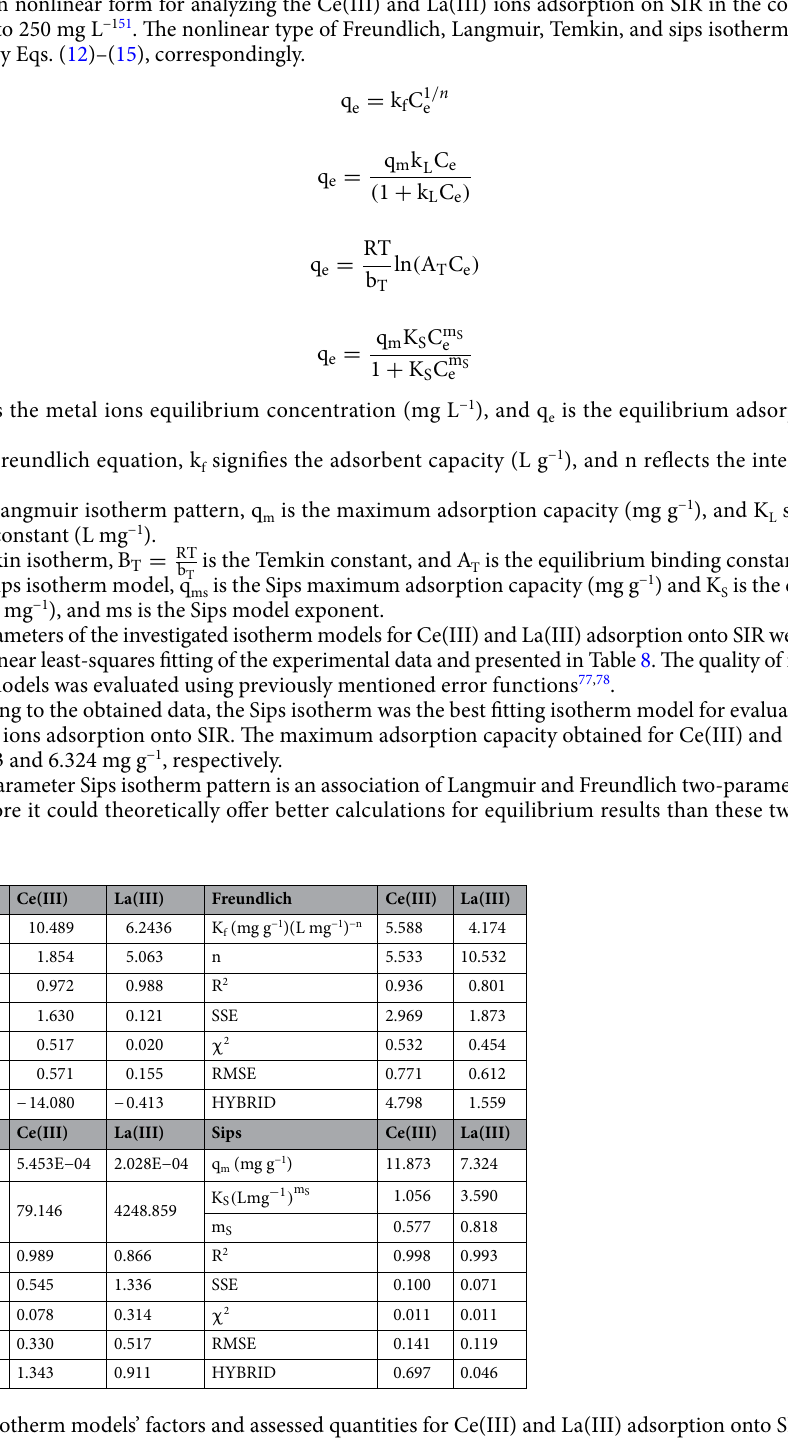
Table 8. Isotherm models’ factors and assessed quantities for Ce(III) and La(III) adsorption onto SIR (pH = 5, SIR dose = 0.4 g, stirring speed = 200 rpm, contact time = 180 min, and temperature = 25 ± 2 °C).